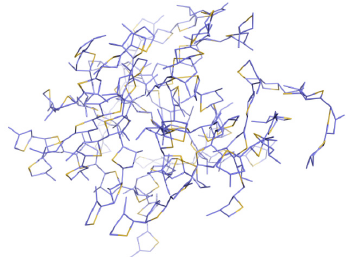
Figure 1. The aggregation of 20 methyl-substituted 5T P3ATs.